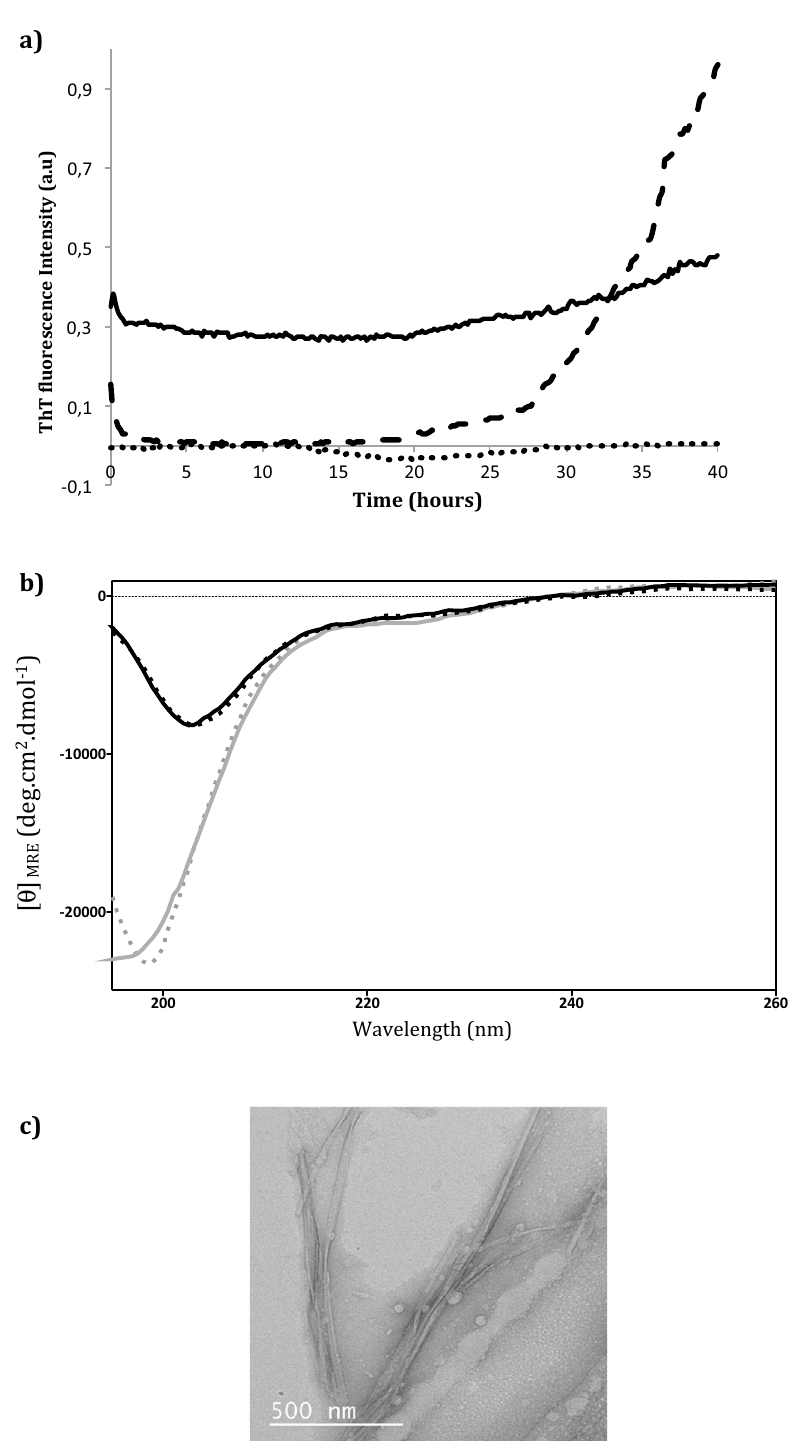
Figure 4. Study of the formation of peptide 1 fibrils. ( a ) Kinetics of formation of fibrils from peptide 1 (black dashed line) and peptide 2 (black dotted line) by ThT fluorescence spectroscopy. Experiments are carried out in water at the concentration of 100 μM and at pH 9.1 (glycine NaOH 0.2 M). ThT is used at the concentration of 10 μM. ERα17p (black line) is the reference. Excitation and emission wavelengths are 440 and 485 nm, respectively. Fluorescence intensity and time are expressed in arbitrary units (a.u.) and hours, respectively. Data are the means of experiments performed in triplicate. Each experiment is carried out over 40 h. ( b ) Kinetics of formation of peptide 1 aggregates recorded by CD. Experiments are performed after an equilibration period of 5 min, at 25 °C and pH 9.1, within the wavelength range 190 and 260 nm and at different incubation times, i.e., at 0 h (grey curve), 5 h (grey dotted lines), 22 h (black curve) and 28 h (black dotted line). CD unit is expressed as mean residue ellipticity [ θ ] MRE (in deg.cm 2 .dmol −1 ). ( c ) TEM image of peptide 1 fibrils at the concentration of 100 μM, after 48 h incubation and at pH 9.1 (glycine NaOH 0.2 M in